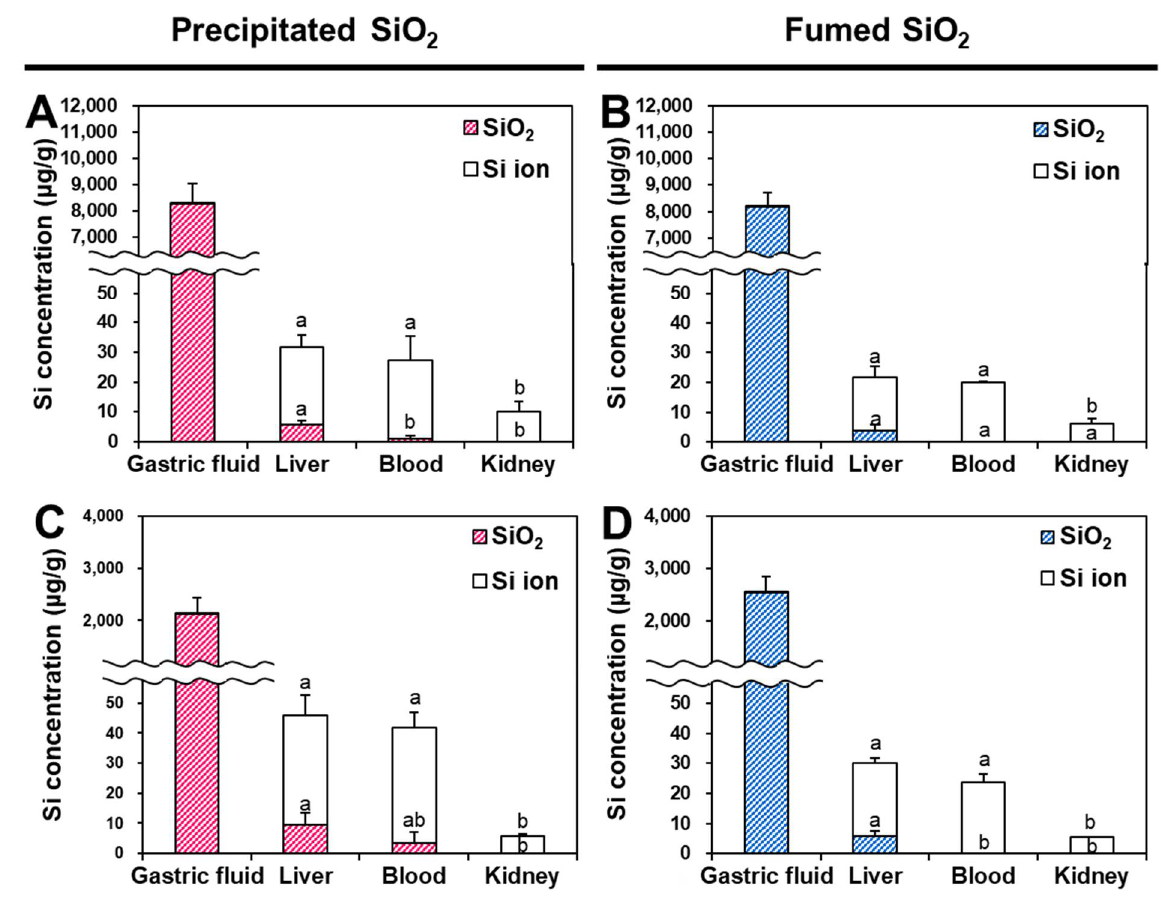
Figure 7. Tissue distribution and fates of ( A , C ) precipitated SiO 2 and ( B , D ) fumed SiO 2 in rats after single-dose oral administration of ( A , B) 300 mg/kg or ( C , D ) 2000 mg/kg, obtained via cloud point extraction (CPE). Different lowercase letters (a,b) indicate significant differences between tissues (liver, blood, and kidney) ( p < 0.05).